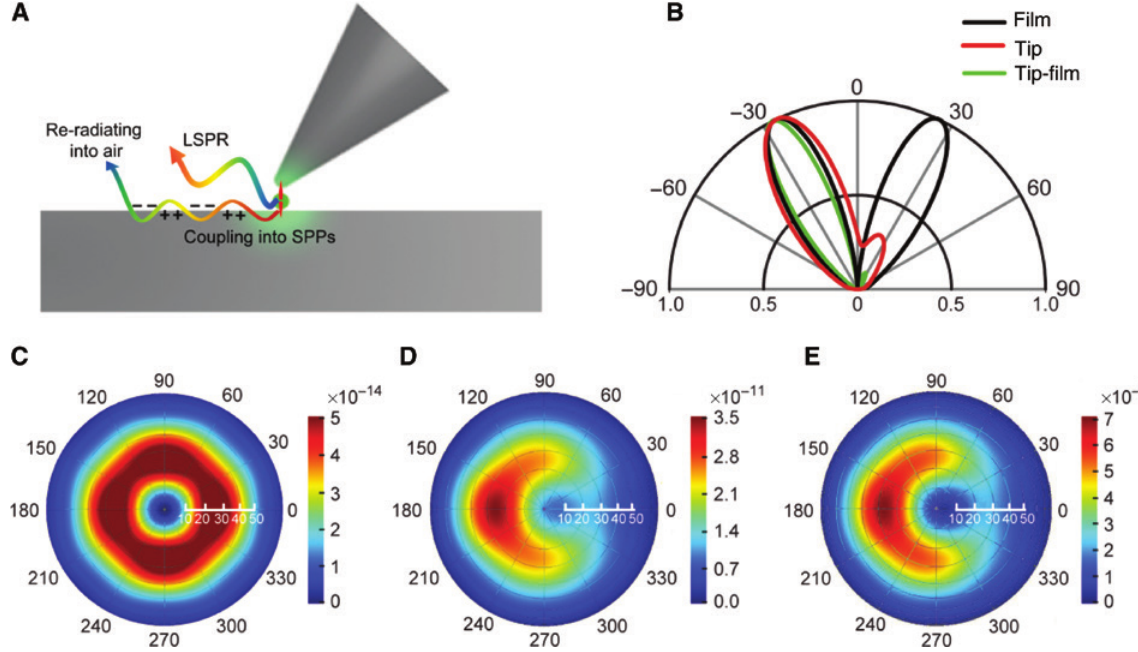
Figure 3: Physical mechanism of LSPR and SPP contributing to the SPCE of TES. (A) The schematic of the synergistic effect of the LSPR and SPP for the SPCE of TES. (B) The angle-resolved emission patterns of the TES in the xz-plane obtained for the single tip, film and tip-film configurations, respectively. All intensities are normalized. (C)–(E) The corresponding far-field scattering spatial distributions for the film, tip and tip-film